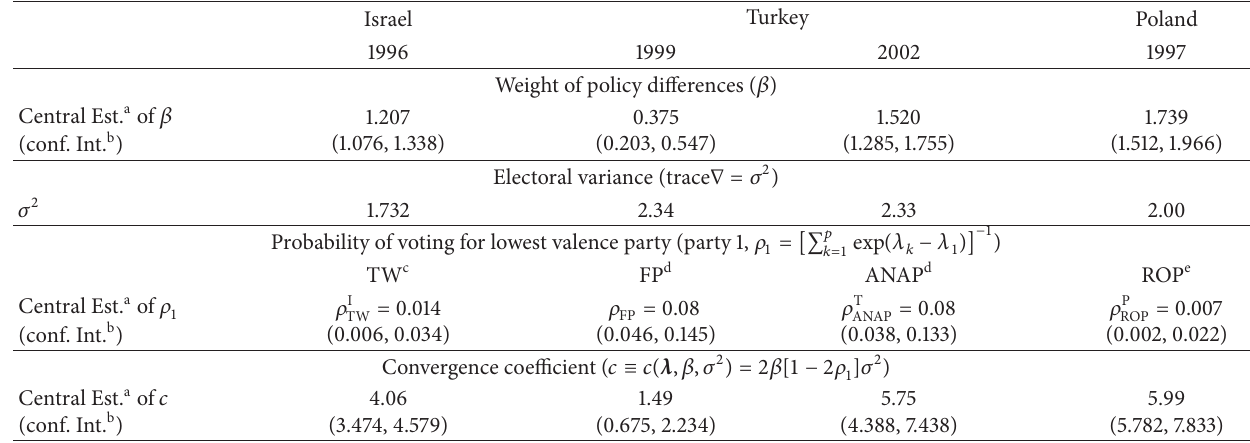
Table 4: The convergence coefficient in proportional